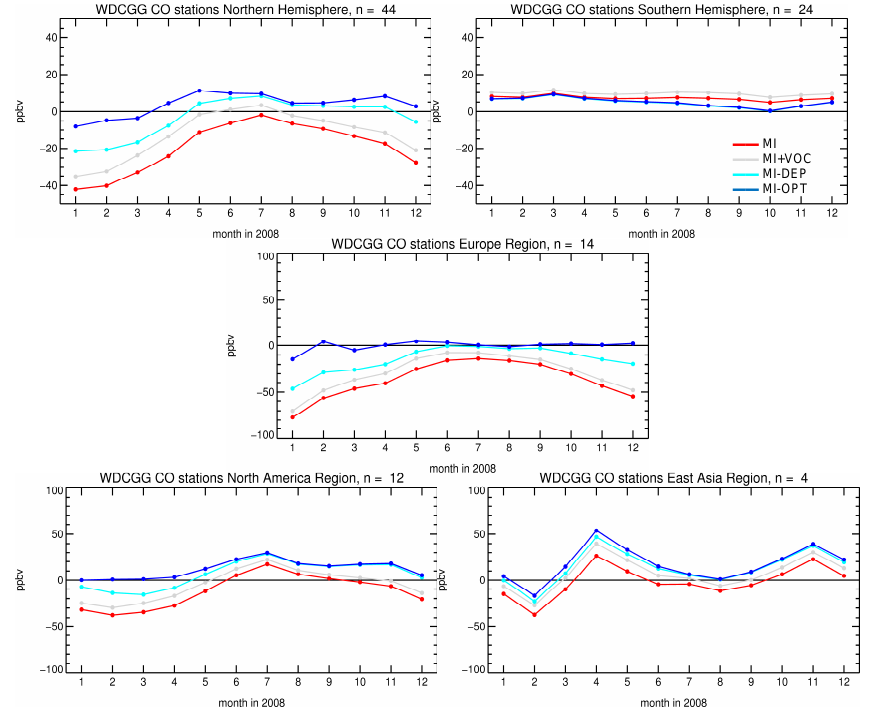
Figure 8. As in Fig. 6 but for the simulations MI (red), MI + VOC (grey), MI-DEP (light blue), and MI-OPT (dark blue).